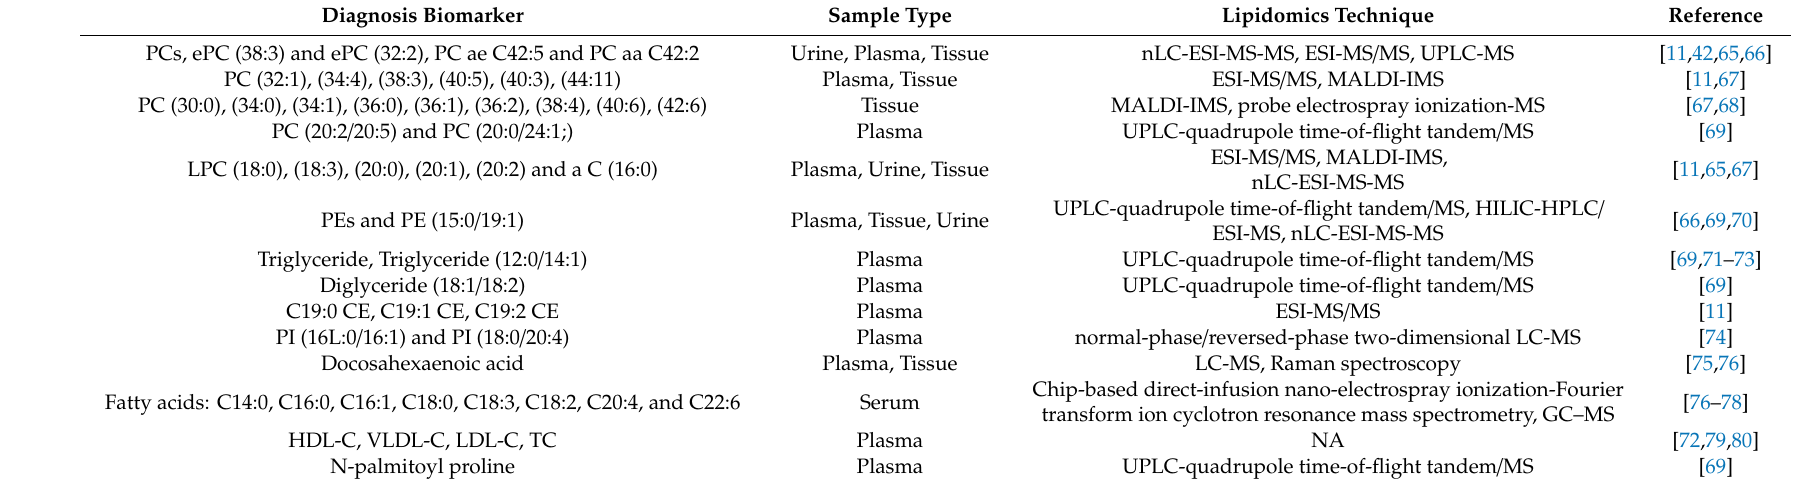
Table 1. Lipids with the ability of early diagnosis in breast